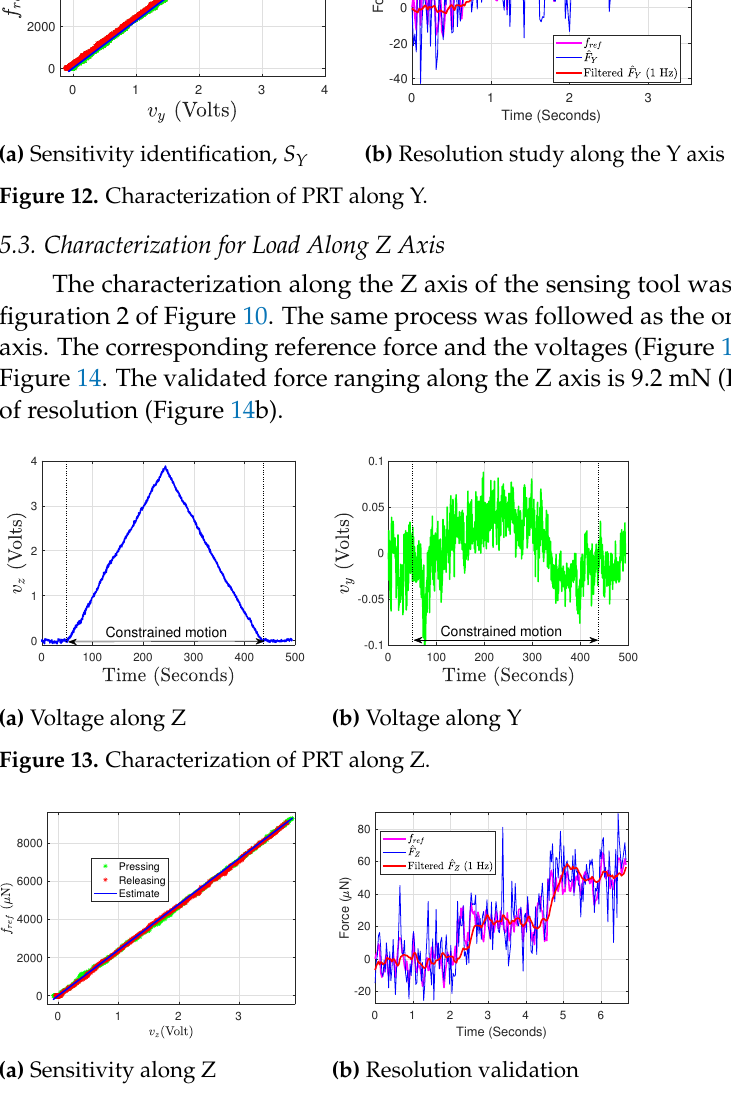
Figure 14. Sensitivity identification and resolution validation under external force along